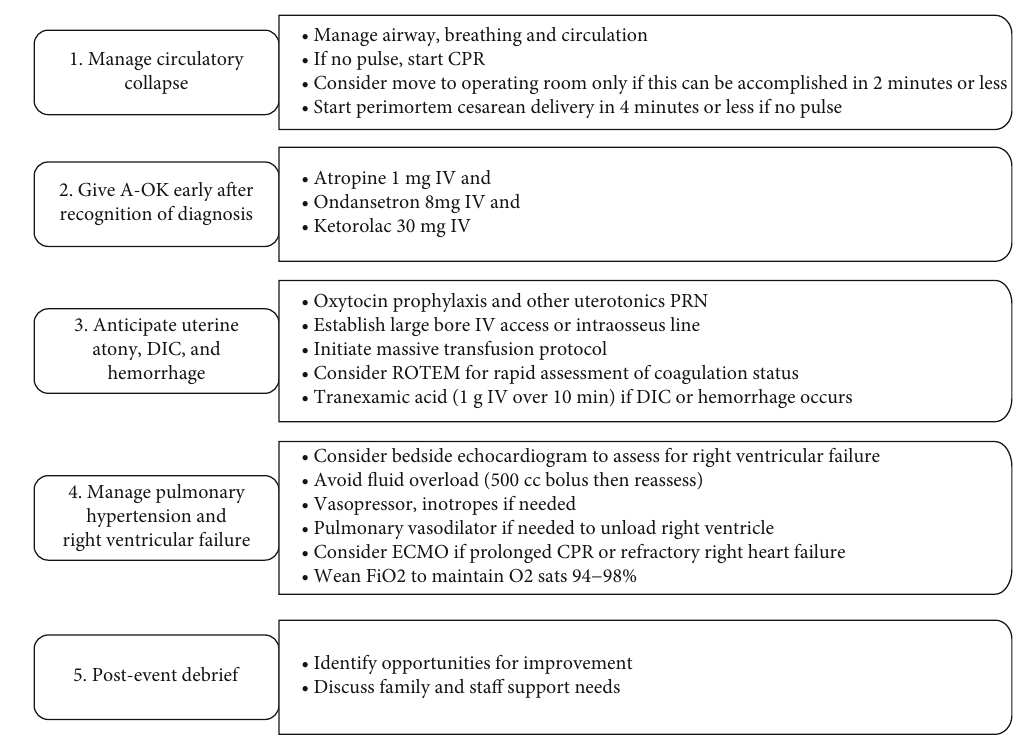
Figure 2: Institutional protocol for AFE which is based on the checklist published by the Society for Maternal Fetal